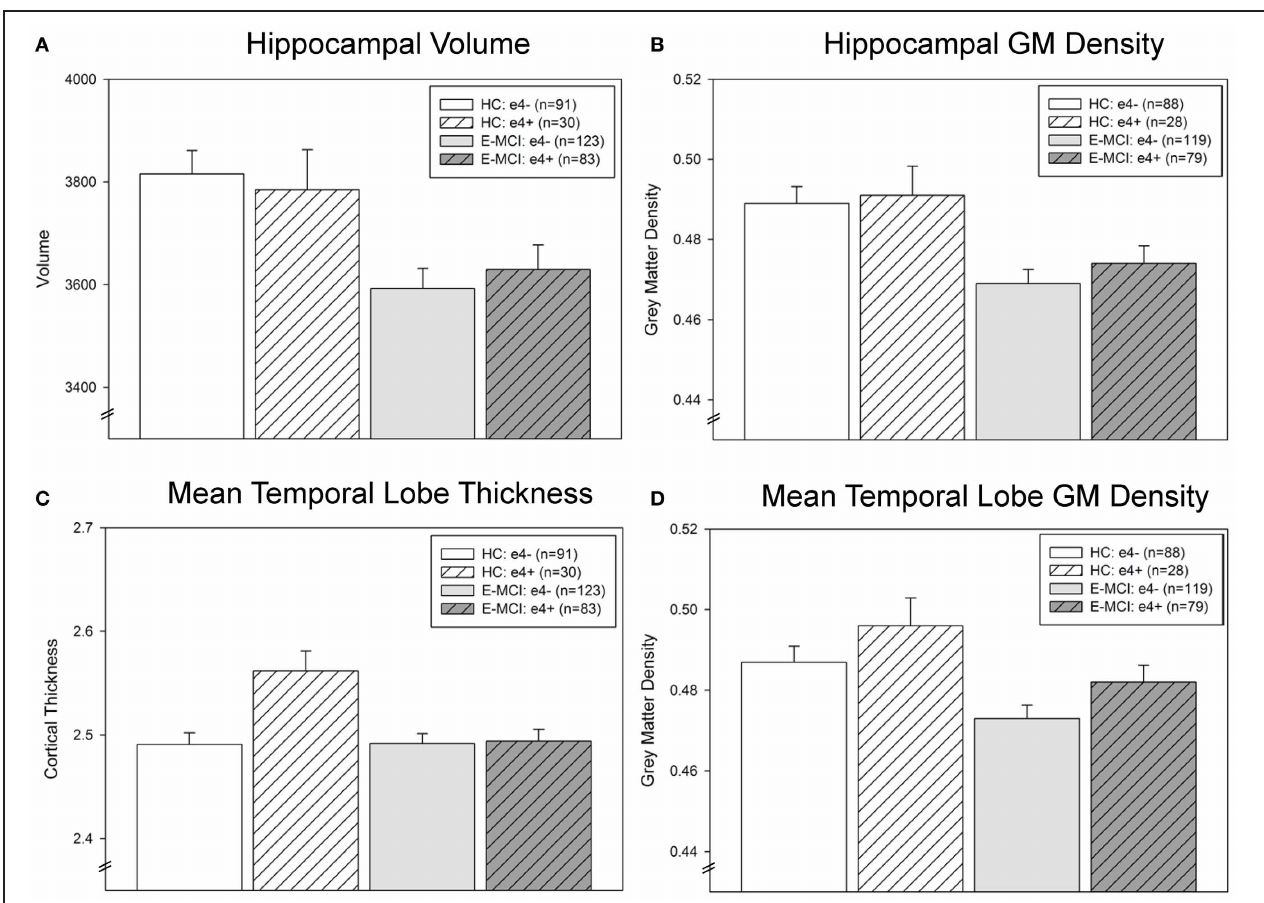
FIGURE 3 | Temporal lobe atrophy is associated with APOE ε 4 status and diagnostic group in E-MCI and HC participants. A significant effect of diagnosis on neurodegeneration in the temporal lobe was observed ( p < 0 . 05), including in hippocampal volume (A) and grey matter (GM) density (B) , mean temporal lobe cortical thickness (C) , and mean temporal lobe GM density (D) . In all evaluated regions, E-MCI participants showed more temporal lobe atrophy than HC participants. In addition, APOE ε 4 status was significantly associated with mean temporal lobe GM density, with APOE ε 4 − participants showing smaller mean temporal lobe GM density than